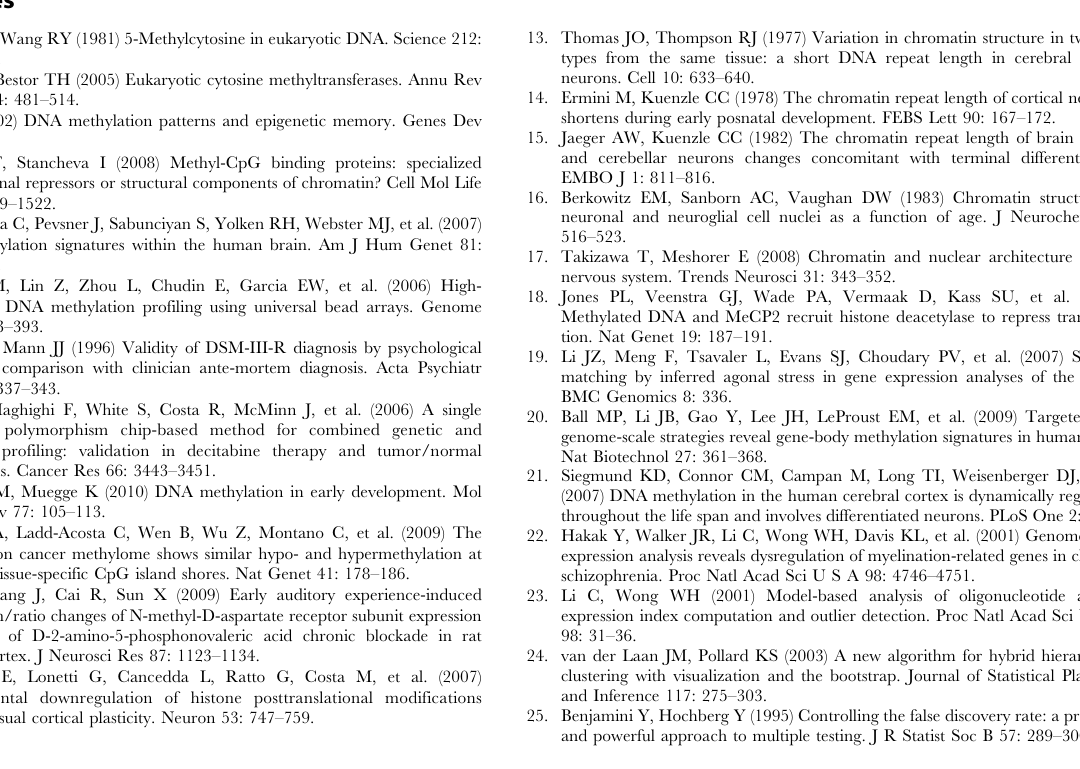
Table S3 Probes that appear to be significantly hypomethylated in cerebellum and hypermethylated in cerebrum. See the description of columns in Table S2. Table S4 Genic probes with known CNS function. See the description of columns in Table